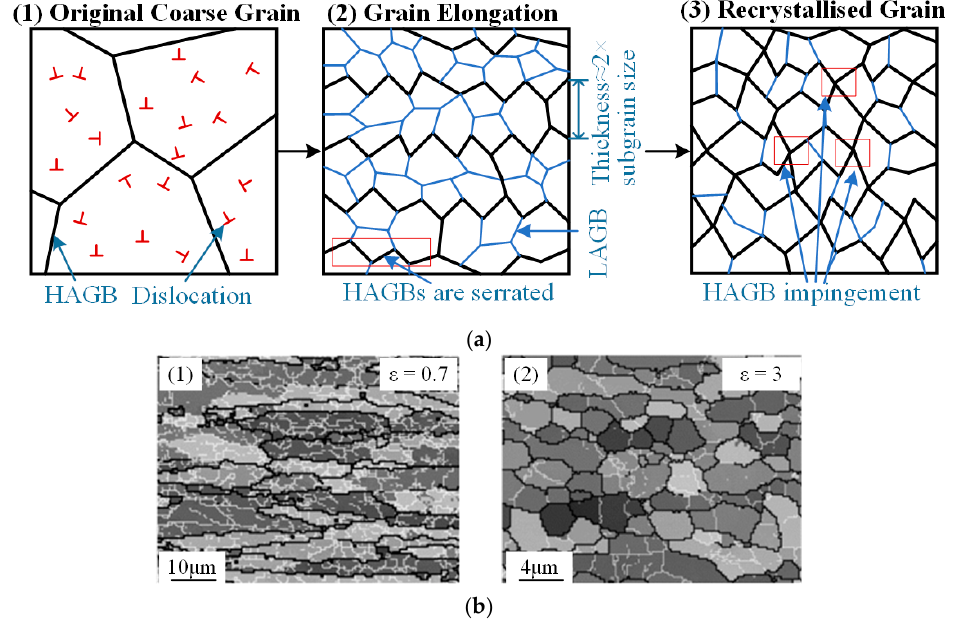
Figure 3. Development of new grains during GDRX: ( a ) schematic illustration, ( b ) experimental observation of as-annealed Al–3Mg–0.2Cr–0.2Fe alloy compressed at 350 °C and 0.1 s − 1 (Reproduced observation of as-annealed Al–3Mg–0.2Cr–0.2Fe alloy compressed at 350 ◦ C and 0.1 s − 1 (Reproduced with permission from Elsevier [55]). with permission from Elsevier